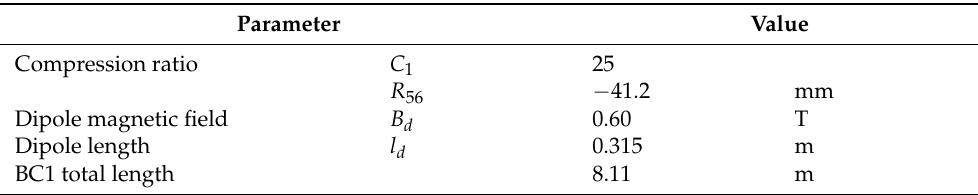
Table 3. BC1 conventional C-chicane design parameters. Parameter Value Compression ratio C